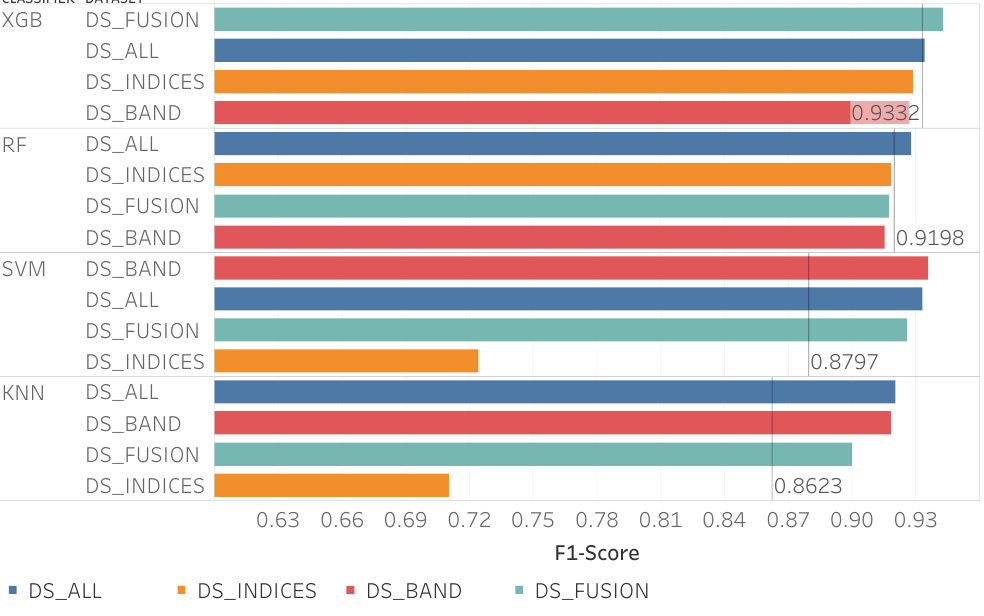
Figure 13. F1-score values for all algorithms and data sets using Sentinel-1 and Sentinel-2 data.